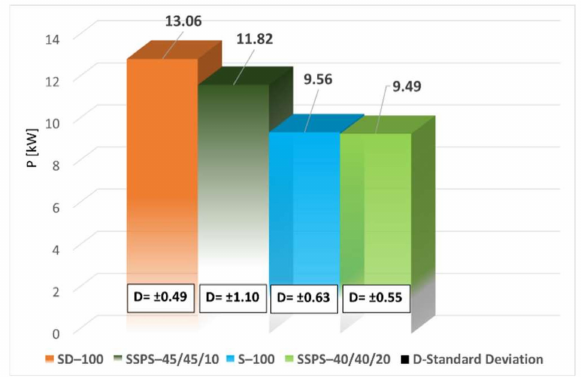
Figure 5. Comparison of the average heat output of the boiler.